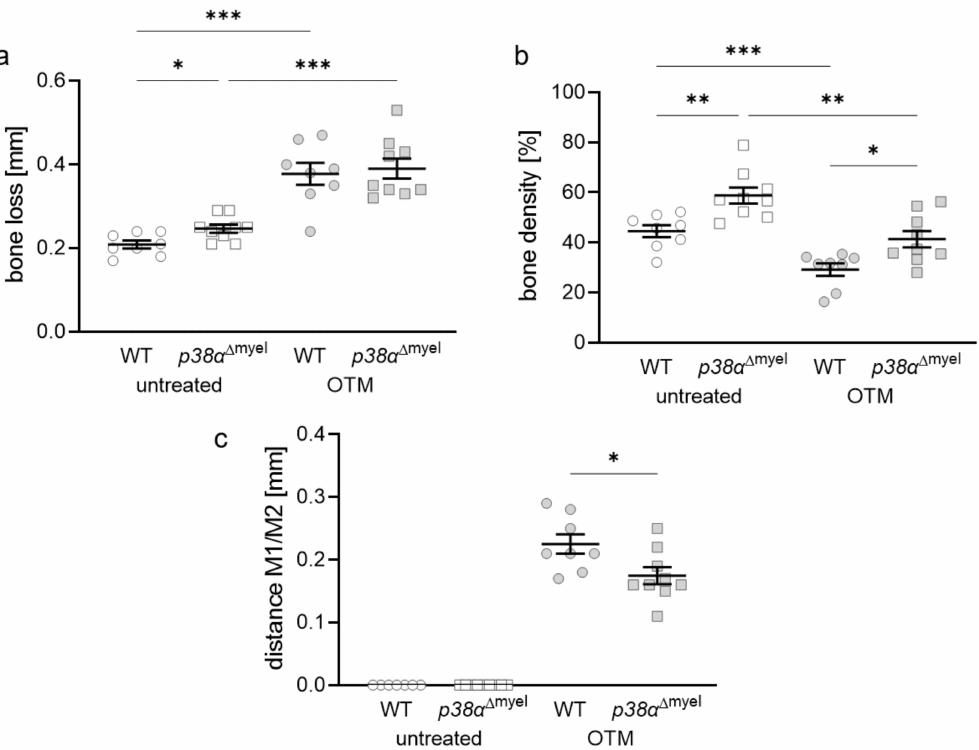
Figure 5. Periodontal bone loss ( a ), bone density ( b ), and orthodontic tooth movement ( c ) as distance between the first (M1) and second (M2) molar at the orthodontically treated (OTM) and the untreated control jaw side in wildtype mice (WT; n = 8) and without p38 α /MAPK in myeloid cells ( p38 ∆ myel mice; n = 9). Each symbol respresents one data point. The horizontal line represents the mean value and the vertical lines represent the standard error. Statistics: ANOVA test followed by unpaired t -test with Welch’s correction, expect ( c ): Mann–Whitney U test, * p < 0.05; ** p < 0.01; *** p <